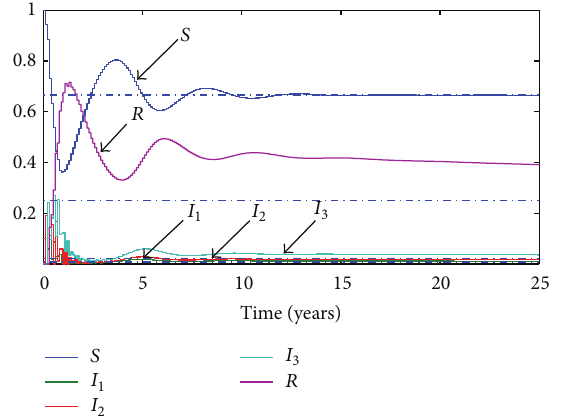
Figure 5: Dynamics of the 𝑆𝐼(3)𝑅 model of the subpopulations for = 1.01 . The dotted lines represent the predicted endemic values. 𝑅 0